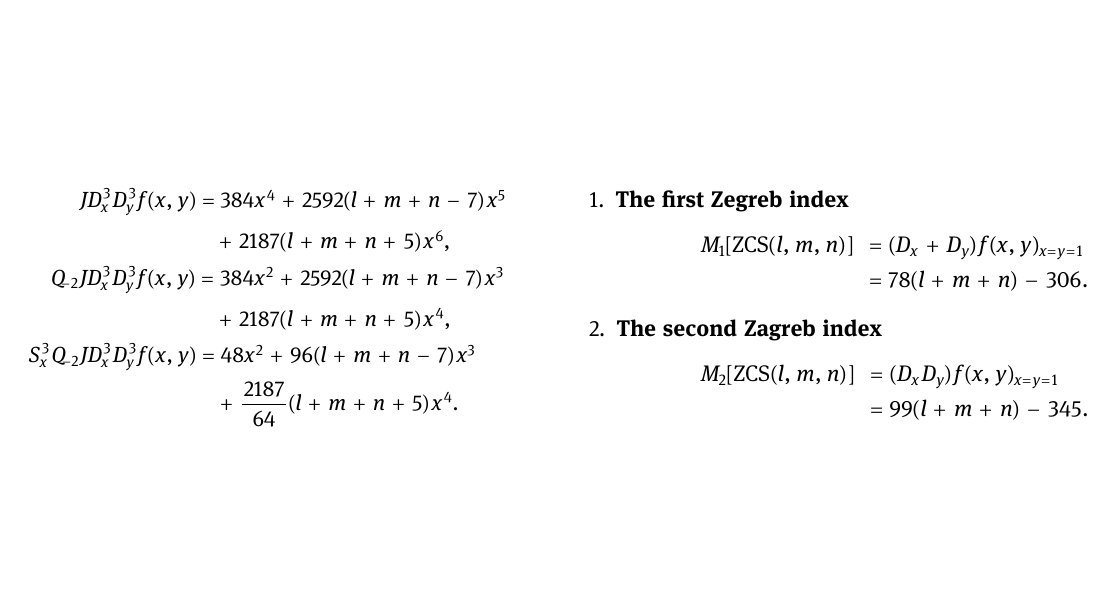
Figure 4: The plot of topological indices of zigzag - edge coronoid fused by starphene ( l m n ZCS , , ( ) ) . ( a ) First Zagreb index, ( b ) second Zagreb index, ( c ) modi fi ed Zagreb index, ( d ) general Randi ć index, ( e ) inverse Randi ć index, ( f ) symmetric division index, ( g ) harmonic index, ( h ) inverse sum index, ( i ) augmented Zagreb